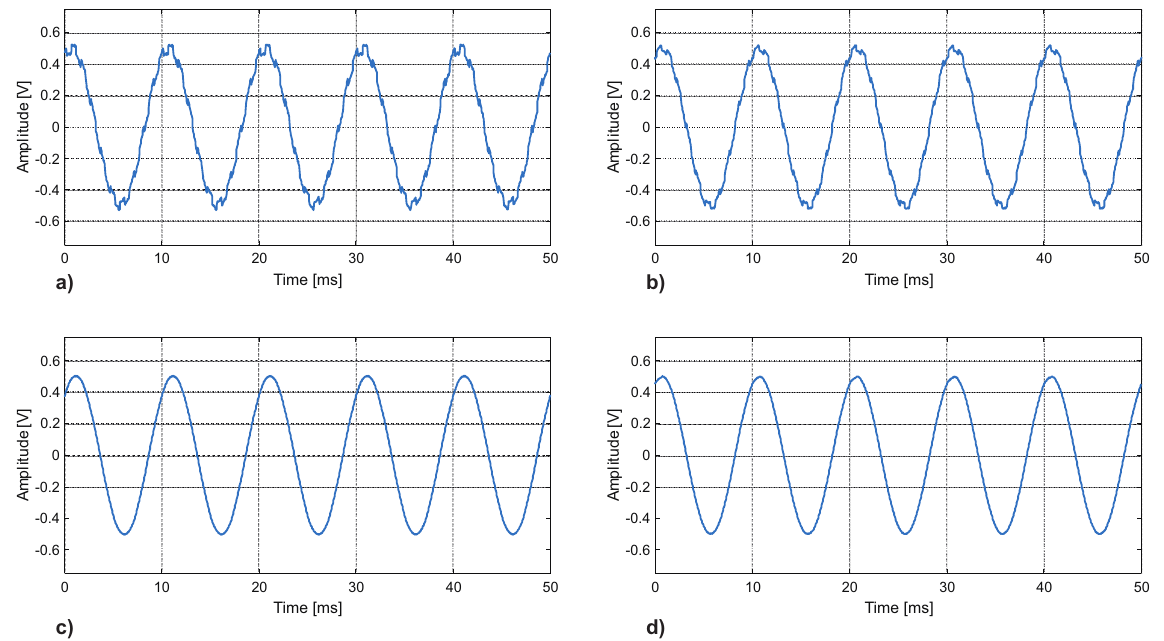
Figure 9. Time-domain waveform of the acquired signals under 0dBm AM EMI excitation: ( a ) OPA2277 opamp output voltage with EMI injection; ( b ) MCP6V02 opamp output voltage with EMI injection; ( c ) OPA2277 opamp output voltage without EMI injection; ( d ) Output voltage with EMI injection estimated starting from the EMI corrupted waveforms in ( a , b ), by the proposed EMI-induced errors suppression procedure with α =